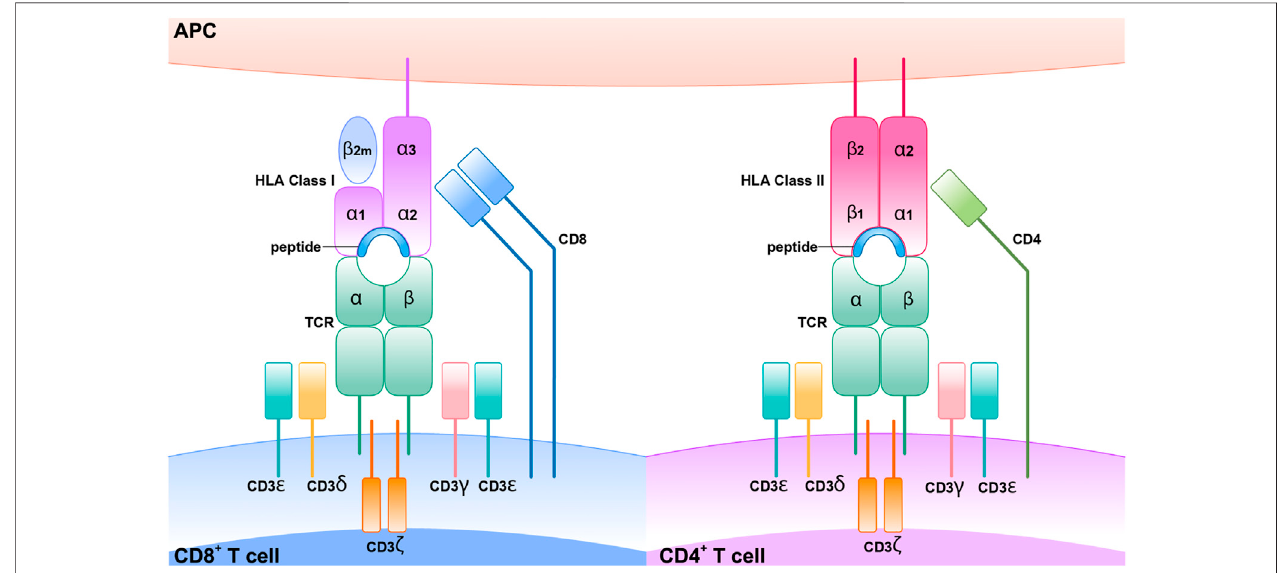
FIGURE 5 | Structure of HLA classes I, II and T cell receptors